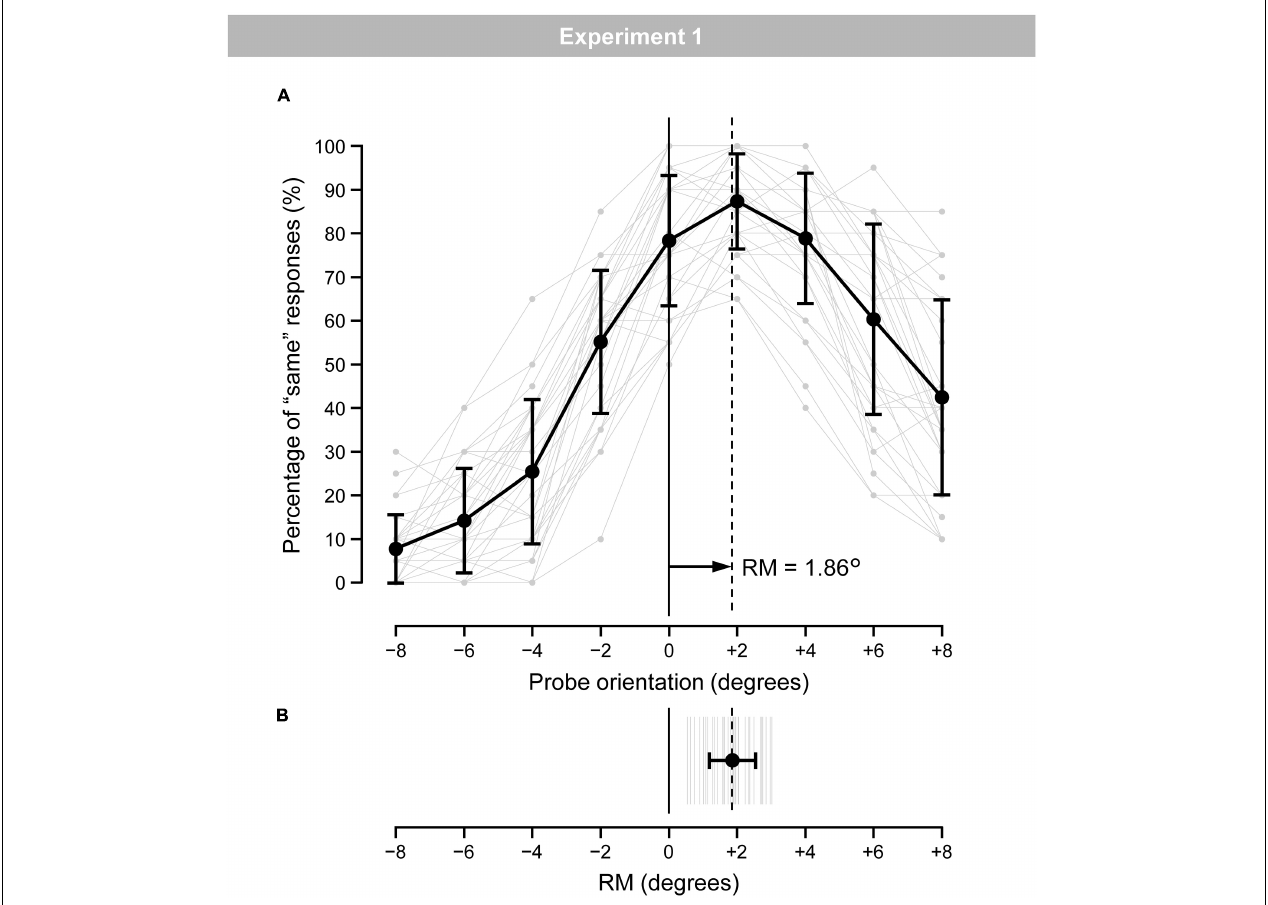
FIGURE 3 | (A) Mean (black) and individual (gray) percentages of “same” responses for the nine probe-orientation categories in the regular trials. Error bars indicate SD . (B) Mean (black) and individual (gray) magnitudes of RM. Error bars indicate SD .